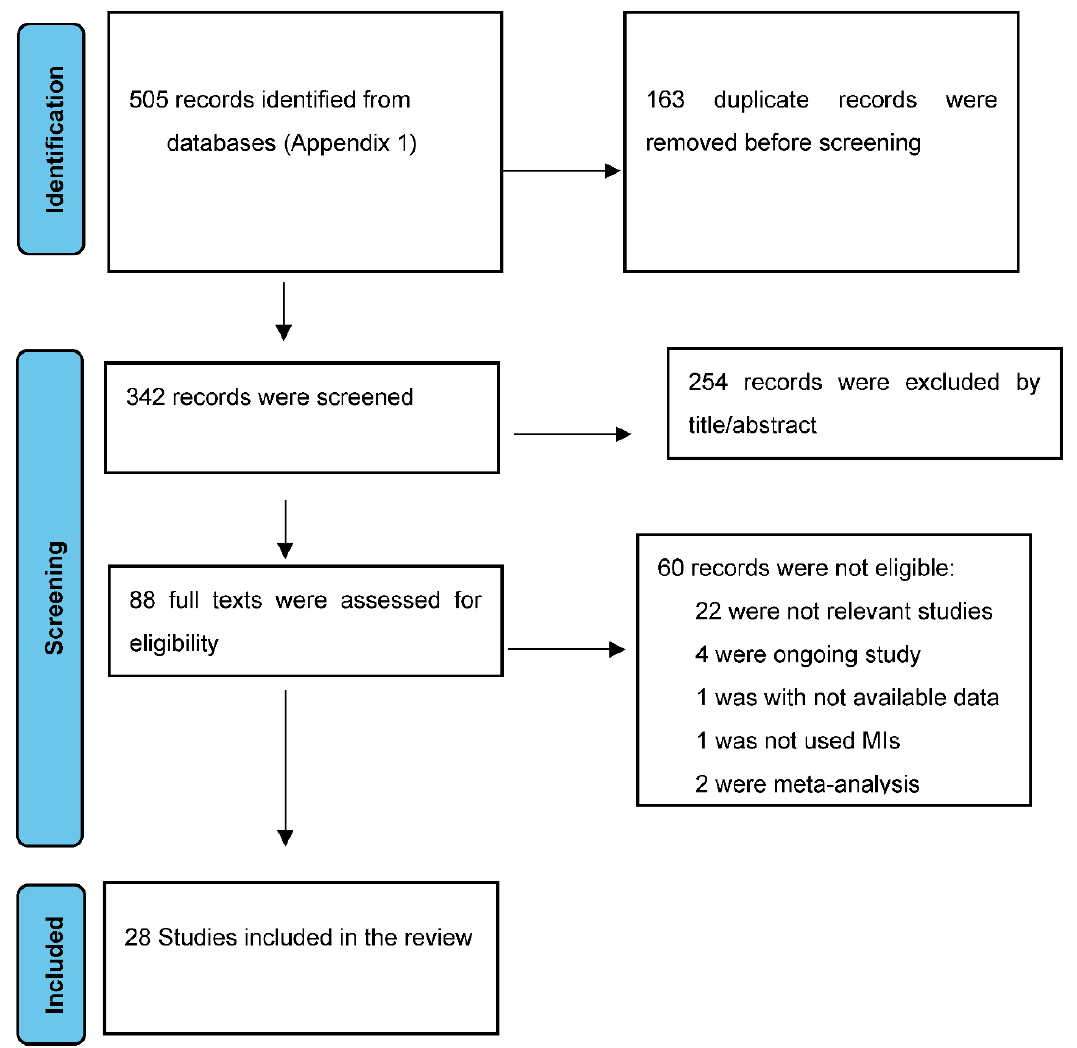
Figure 1. The PRISMA flow diagram of the study.